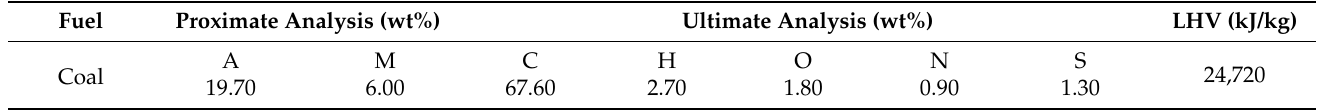
Table 5. Properties of the fuel used by CFPU (as received basis).